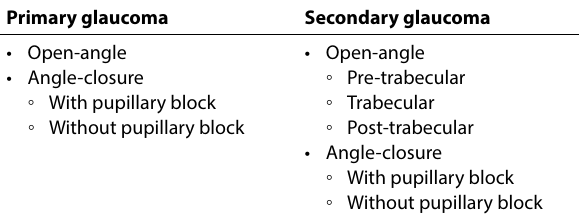
Table II: Classification of glaucoma 9-10 Primary